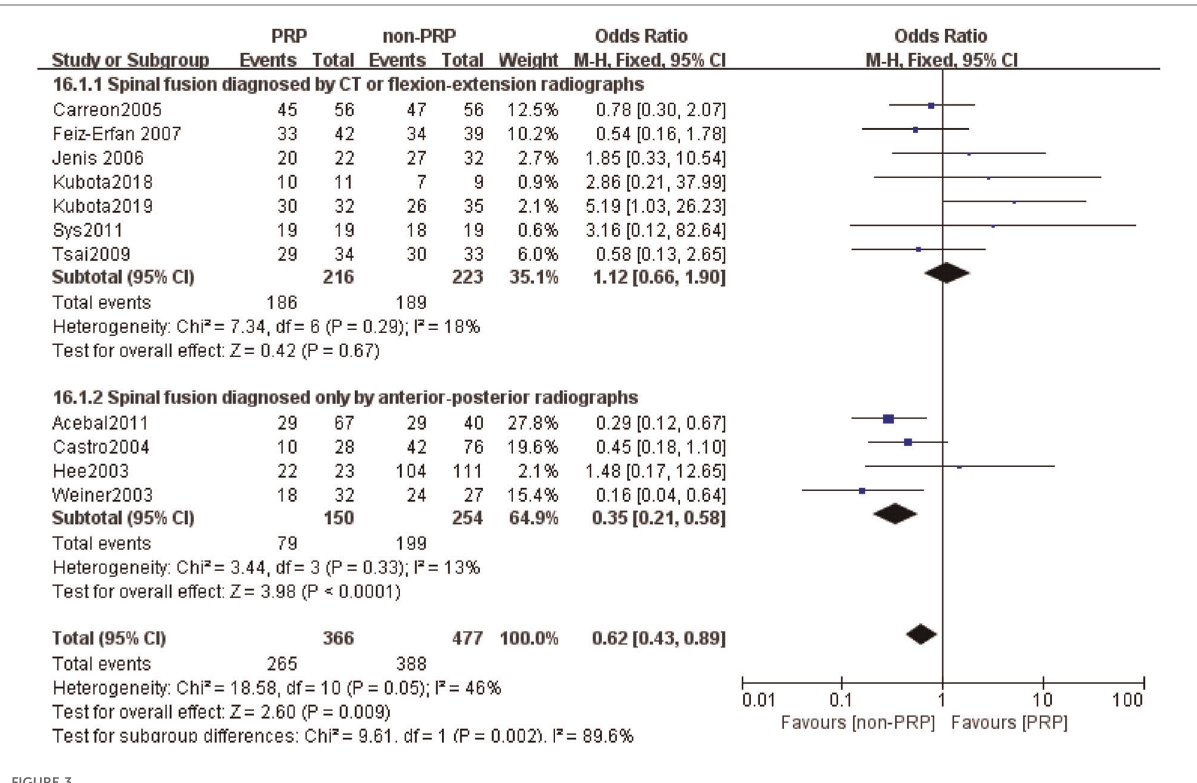
FIGURE 3 Subgroup analysis according to the spinal fusion evaluation